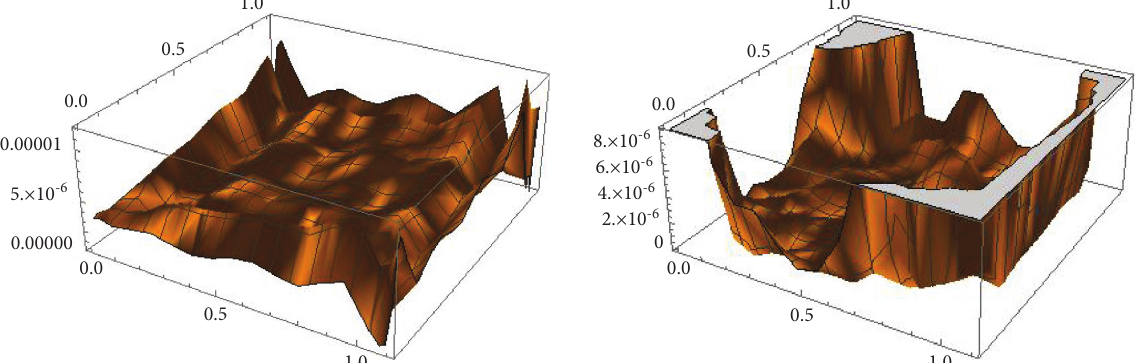
Figure 2: The plot 3D errors for both mesh and meshless points.